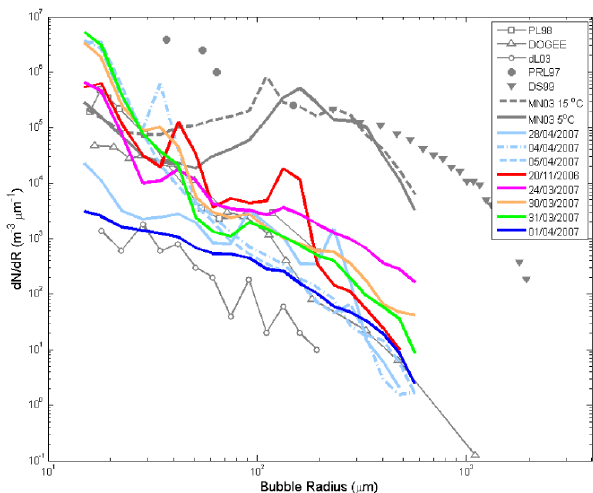
Fig. 5. Mean bubble spectra for each buoy deployment (coloured lines, pale blue lines are cases where no corresponding aerosol mea- surements are available). A number of previous measurements are shown for comparison (grey lines). The open ocean spectra (open symbols) of de Leeuw et al. (2003) (dL03, U = 5 . 8ms − 1 ), Phelps and Leighton (1998) (PL98, depth 0.5m, U = 12 − 14ms − 1 ), and measurements by Leighton and Coles, summarized in Brooks et al. (2009a) and Pascal et al. (2011) (DOGEE, averaged over a depth of 0–3m, U = 13ms − 1 ), and the surf zone spectra (filled sym- bols) of Phelps et al. (1997) (PRL97), and Deane and Stokes (1999) (DS99) along with the laboratory bubbles spectra of M ˚ artensson et al. (2003) at 5 ◦ C (solid grey line) and 15 ◦ C (dashed grey line) are shown for comparison. The Deane and Stokes (1999) measurements are restricted to actively breaking regions of